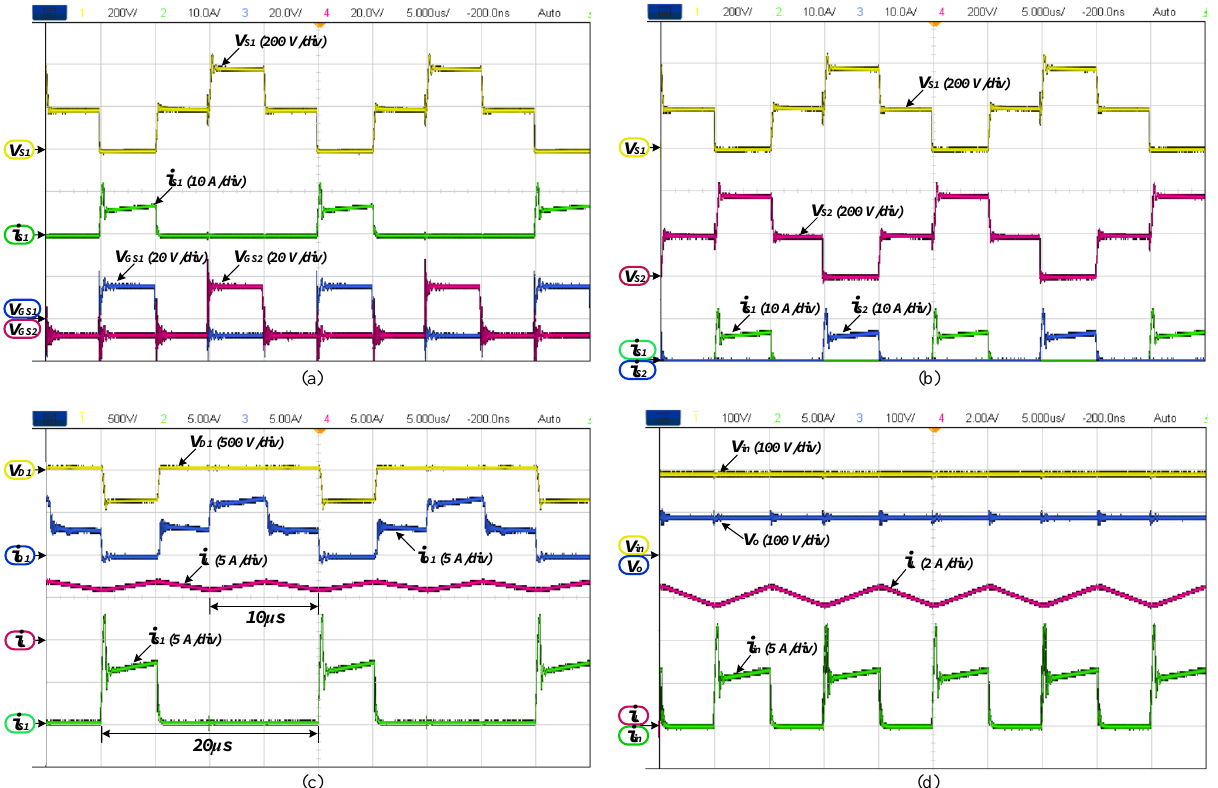
Figure 11. 3SSC-A-based buck-boost experimental results at full load (time: 5 µ s/div.): ( a ) v S (200 V/div); i S (10 A/div); V GS (20 V/div); V GS (20 V/div); ( b ) v S 2 1 1 i S (10 A/div); i S (10 A/div); ( c ) v D (200 V/div); i D (5 A/div); i L (5 A/div); i S 1 1 2 1 (100 V/div); i L (2 A/div); v in (100 V/div); i in (5 A/div).